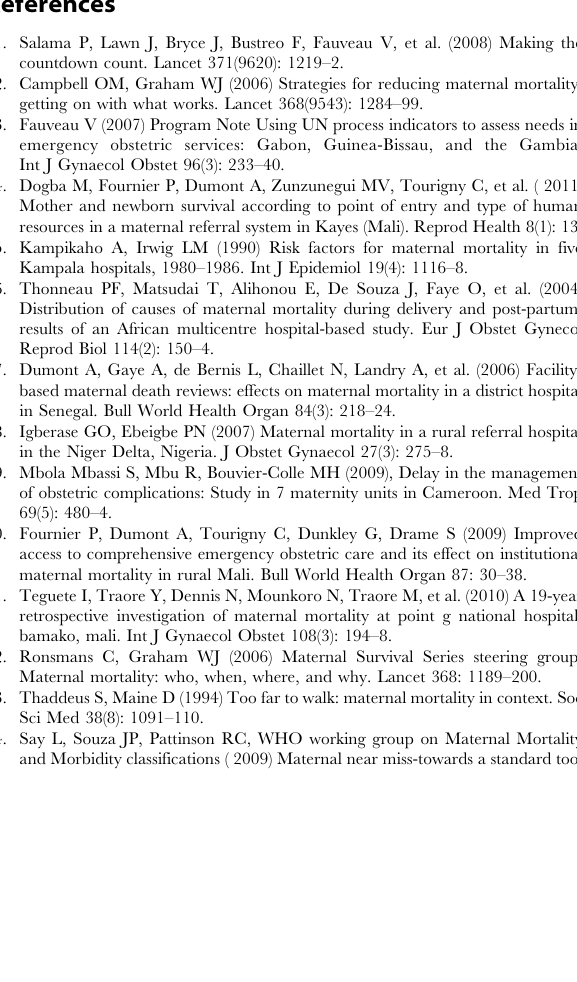
Table S1 List of variables used for predicting in- hospital maternal mortality